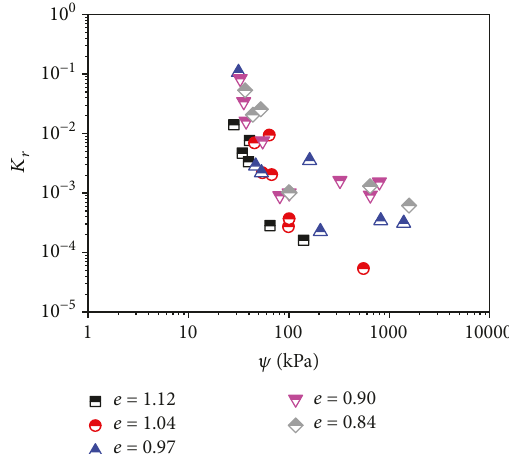
Figure 4: Measurement of the relative hydraulic conductivity of deformable Hunan clay.